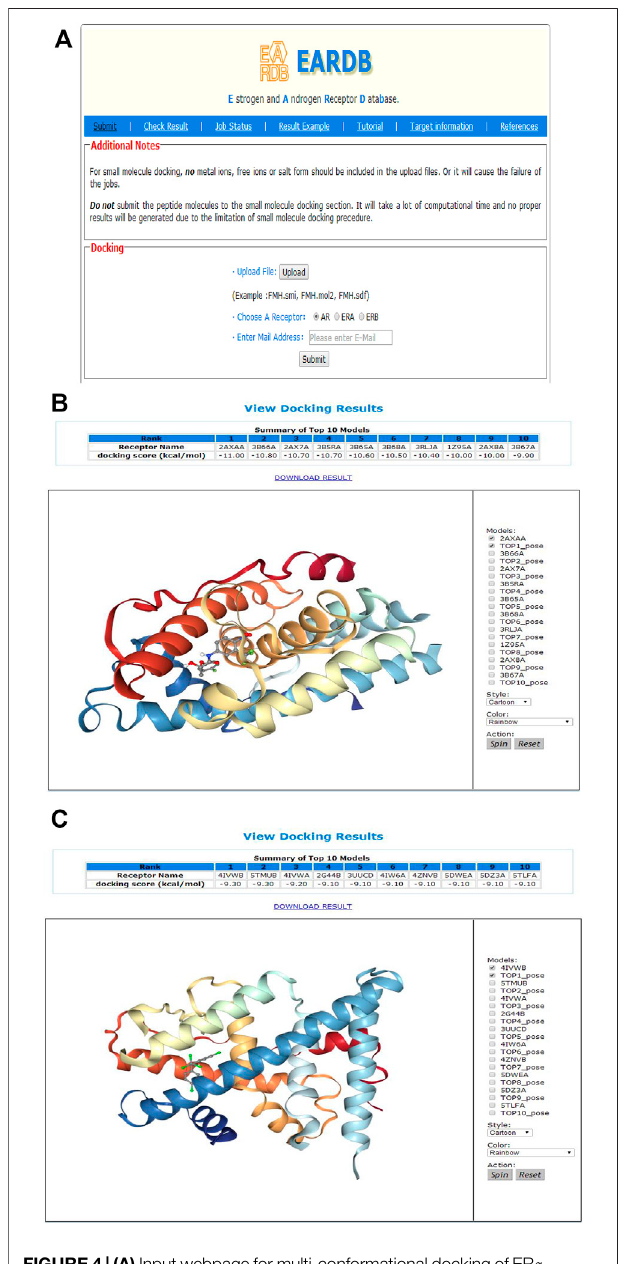
FIGURE 4 |(A) Input webpage for multi-conformational docking ofER α , ER β , or AR; (B) The result page of multi-conformational docking (example running for FHM); (C) The result page of multi-conformational docking (example running for